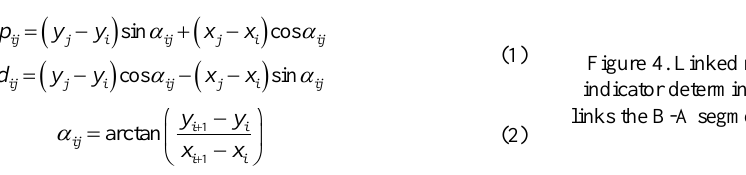
Figure 2. Correspondences between two polygon features